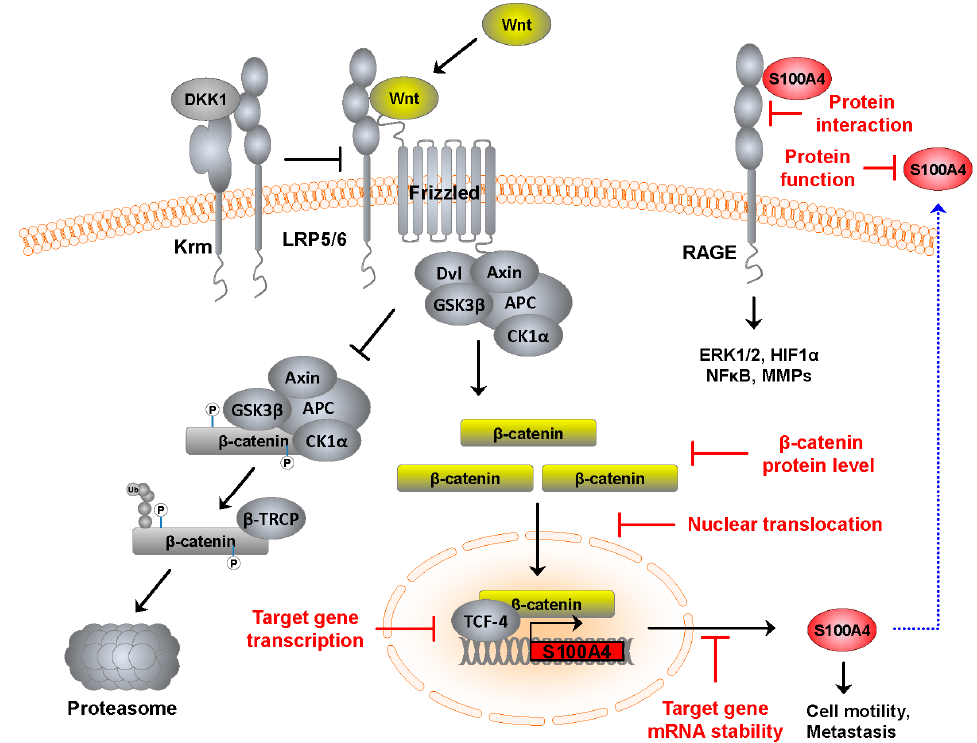
Figure 1. Schematic representation of the Wnt signaling pathway and possible points for therapeutic interventions to restrict S100A4 ‐ mediated tumor progression and metastasis. Possible therapeutic intervention points downstream of active Wnt signaling complexes act via reducing β‐ catenin levels, lowering its nuclear accumulation, and/or inhibiting the formation of active target gene (here S100A4) transcription complexes by small molecules. The expression of specific target genes, such as S100A4, can be reduced by targeting its mRNA level by RNAi. Inhibition of intracellular S100A4 protein function is possible via small molecules. Inhibition of extracellular S100A4 can be achieved with S100A4 ‐ specific antibodies, interactions with its receptor (here RAGE) by using receptor ‐ specific antibodies. Without active signaling, β‐ catenin has a rather short half ‐ life in the cytoplasm, since it gets phosphorylated by the so called “destruction complex”, consisting of glycogen synthase kinase (GSK)